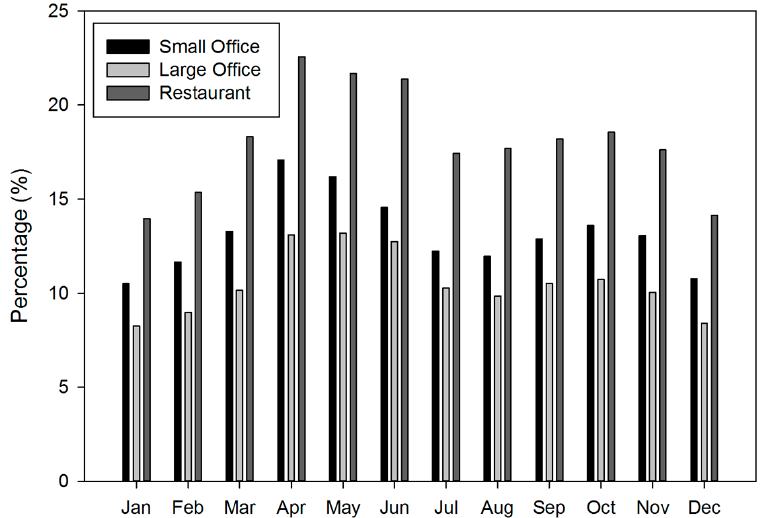
Figure 6. Monthly percentage of CDE savings for each of the modeled buildings.